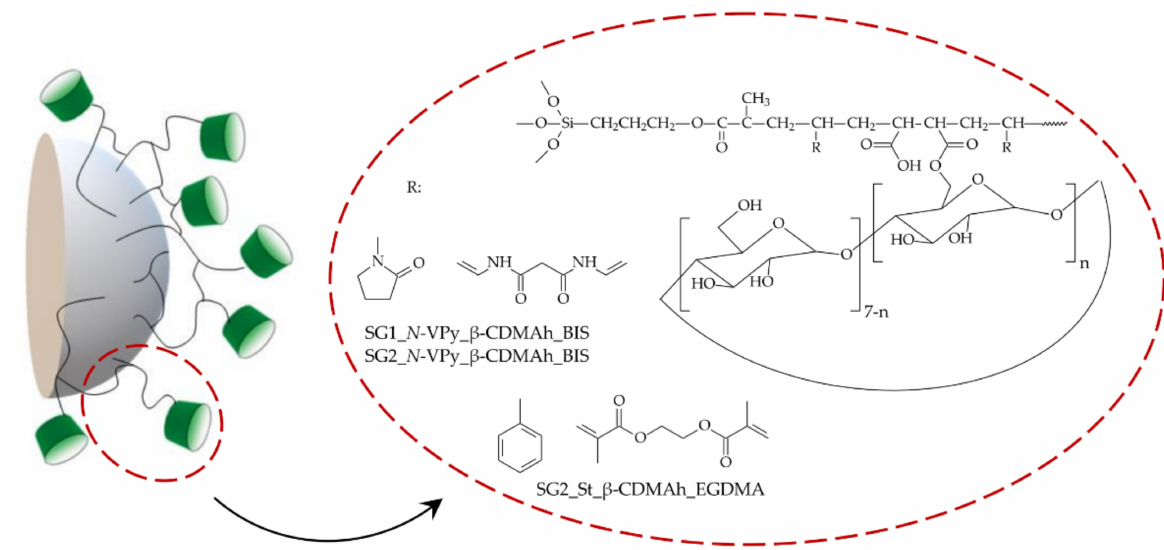
Figure 5. ATR-IR spectra: (top) silica gel; (middle) β -CD; (bottom) SG1_N-VPy_ β -CDMAh_BIS. The IR spectrum of an analogous polymer on silica gel modified using method 2 (SG2_ N -VPy_ β -CDMAh_BIS) is shown in Figure 6.